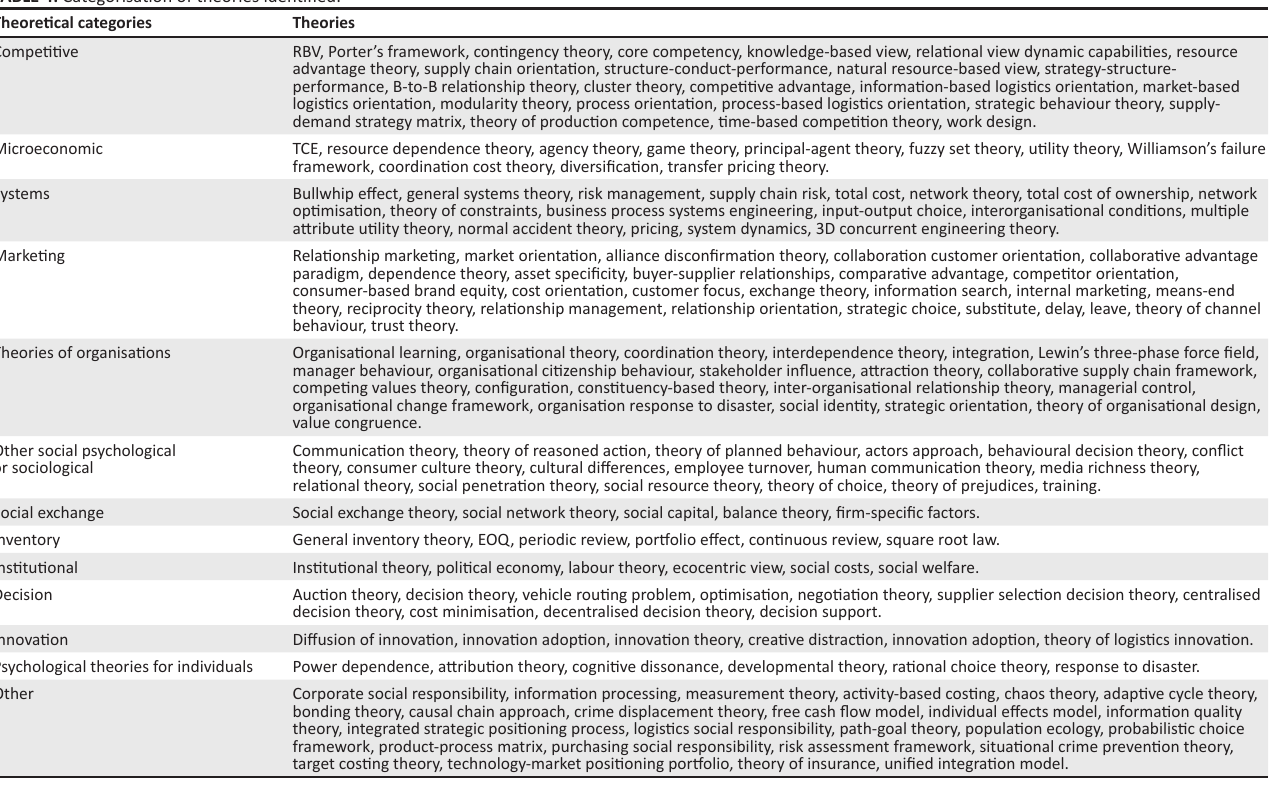
TABLE 4: Categorisation of theories identified.